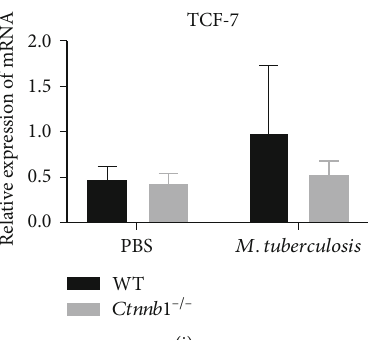
Figure 2: The expression of IFN- γ and TNF- α in CD3 + and CD4 + T cells. (a, b) IFN- γ + CD4 + T cell in the lungs and spleens of Ctnnb1 -/- mice ( n = 5 ) and wild-type mice ( n = 5 ) infected with or without M. tuberculosis . (c, d) TNF- α + CD4 + T cell in lungs and spleens of Ctnnb1 -/- mice ( n = 5 ) and wild-type mice ( n = 5 ) infected with or without M. tuberculosis . (e, f) CD69 + CD3 + CD4 + T cells in the lungs and spleens from Ctnnb1 -/- mice ( n = 5 ) and wild-type mice ( n = 5 ) infected with or without M. tuberculosis . (g, i) mRNA of IFN- γ , TNF- α , and TCF-7 in the lungs of Ctnnb1 -/- mice ( n = 5 ) and wild-type mice ( n = 5 ) infected with or without M. tuberculosis . The experiment had three independent rounds, and results were analyzed by the unpaired Student t -test. PBS, phosphate-bu ff ered saline.